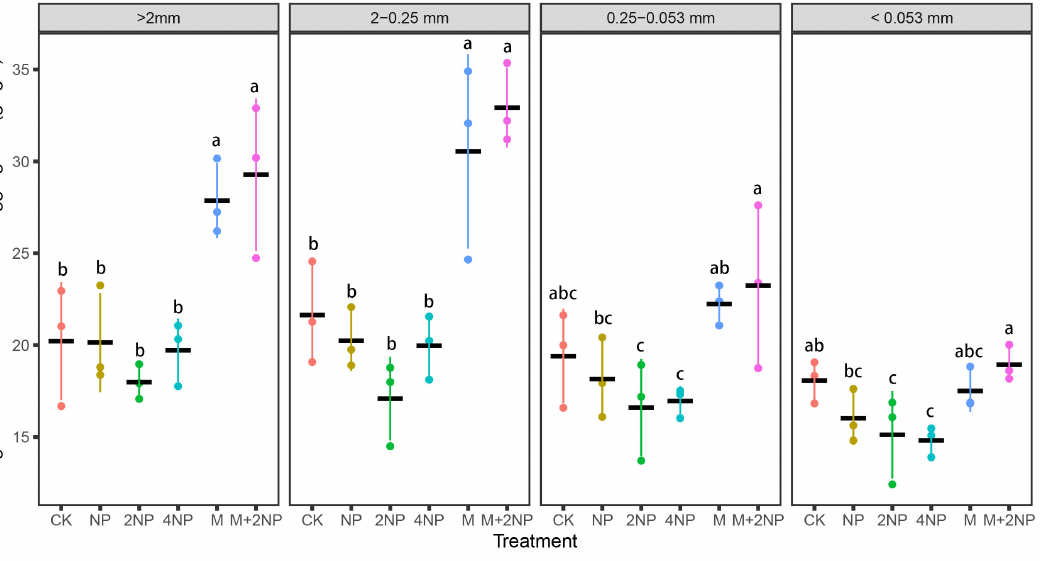
Figure 3. Organic carbon content of soil aggregates. The black horizontal and colorful vertical lines represent the mean and SD, respectively, and the dots next to them represent the respective measured values. Different lowercase letters show significant differences among fertilization treatments in the same aggregate fractions (P < 0.05). Values are given as means ± SD (n = 3). Abbreviations: CK = no fertilizer; NP = low − dose chemical fertilizer; 2NP = moderate − dose chemical fertilizer; 4NP = high − dose chemical fertilizer; M = normal − dose organic fertilizer; M+2NP = normal − dose organic fertilizer + moderate − dose chemical fertilizer.